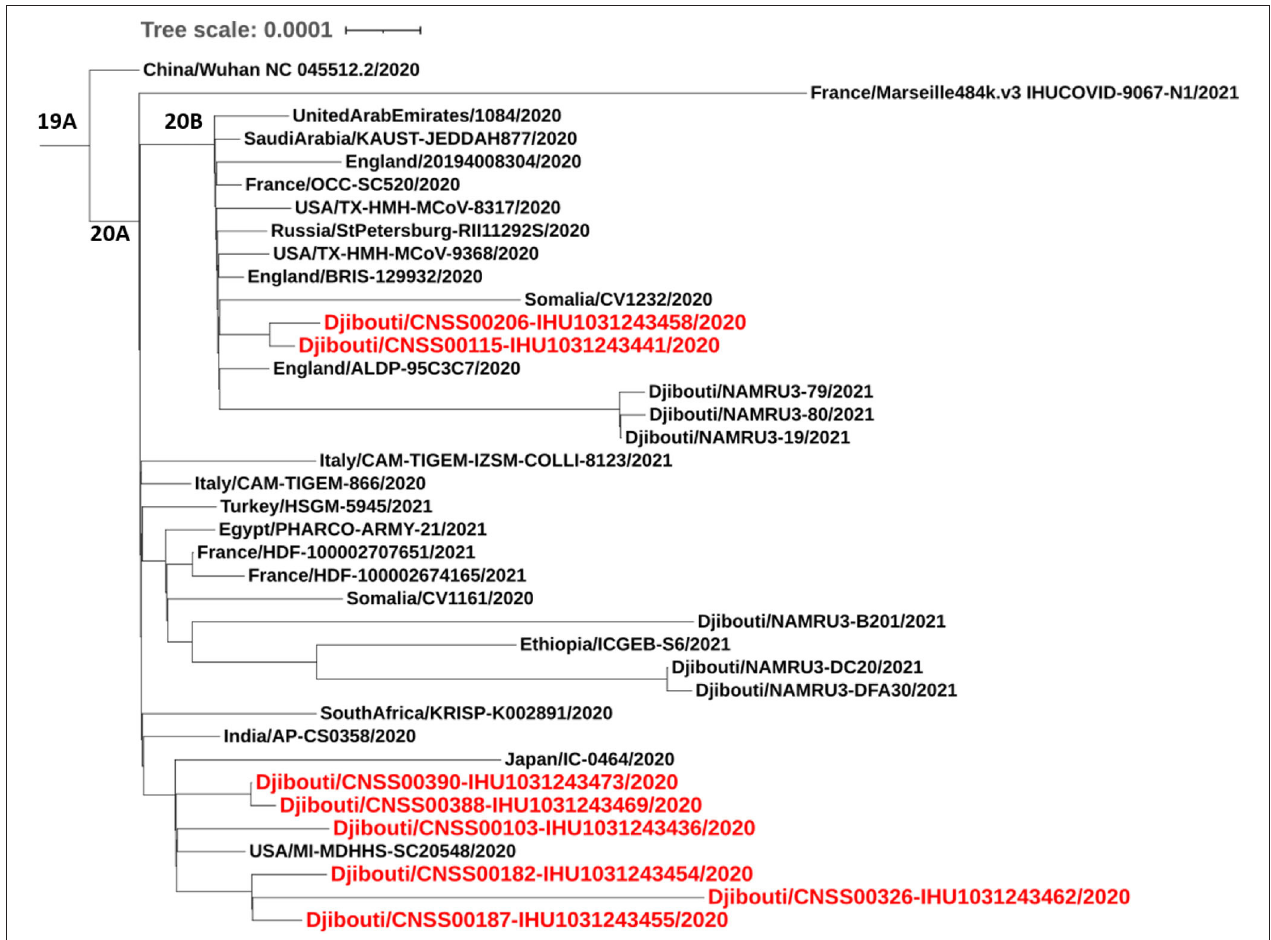
FIGURE 5 | Phylogenetic tree (obtained using the IQ-TREE software with the GTR Model and 1,000 ultrafast bootstrap 84 repetitions), including height SARS-CoV-2 strains from the first COVID-19 wave in Djibouti compared to 23 SARS-CoV-2 sequences (clades 19B, 20A, 20B), available through GISAID.